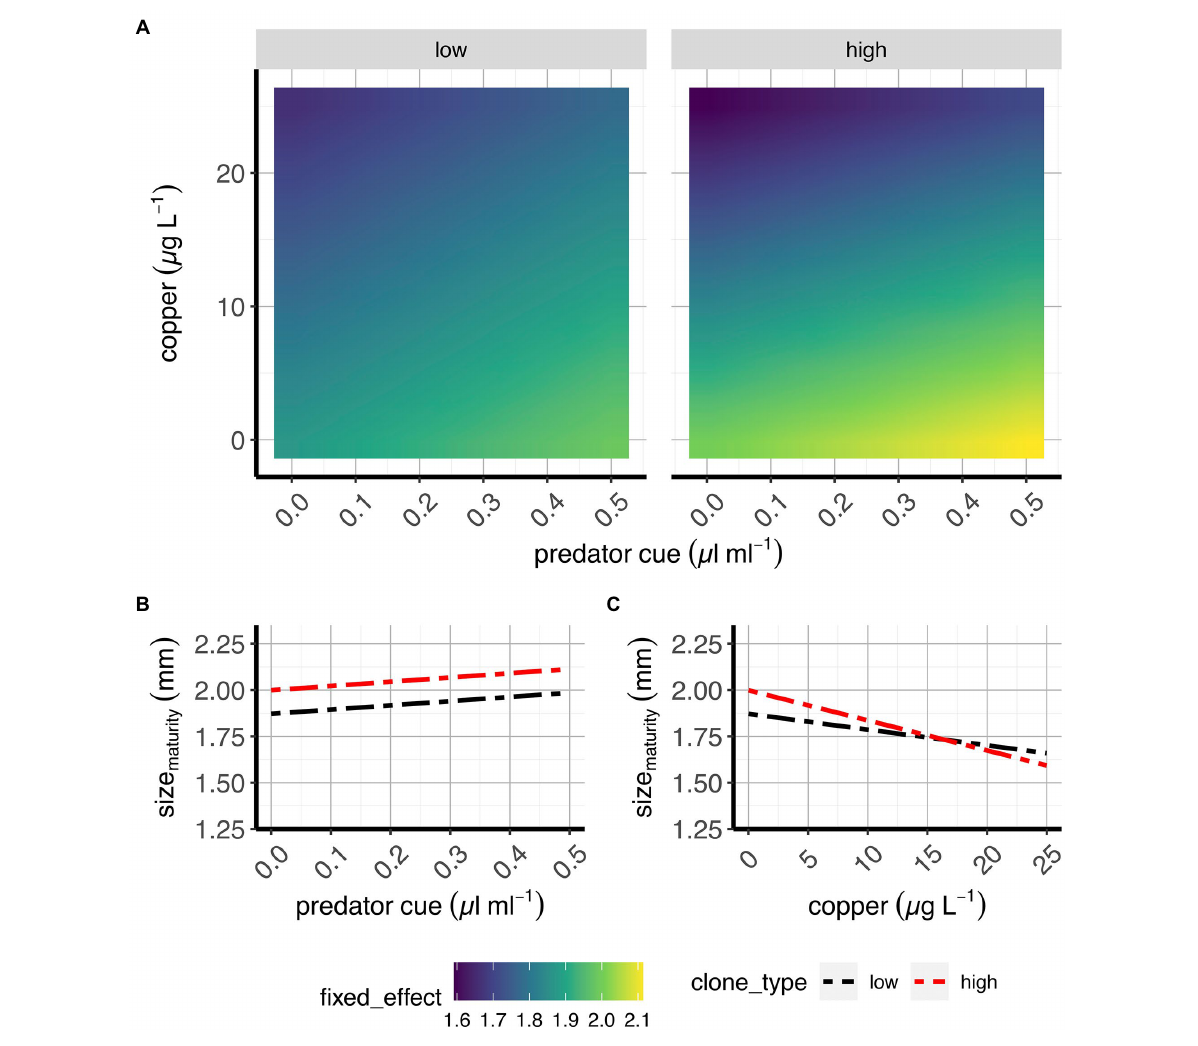
FIGURE 3 Size at maturity in two classes of D. pulex genotypes. (A) Contour plots of the average fixed effects portion of the model showing the overall response (here: size at maturity) to copper and predation in “high inducers” and “low inducers.” (B,C) Average effects of risk of predation (B) and sub-lethal copper concentrations (C) on size at maturity when copper and risk of predation, respectively, are absent (e.g., references for each treatment). X-axes present predator cue (A,B) or copper concentrations (C) , and y-axis denote copper concentrations (A) or size at maturity estimates (B,C)